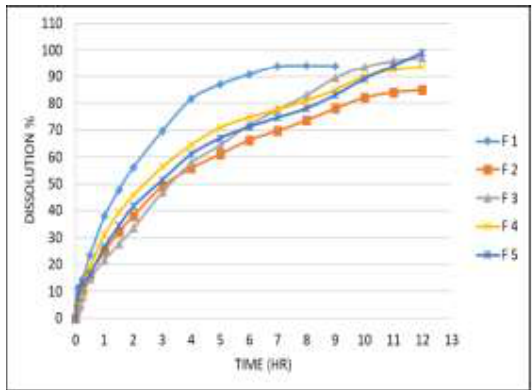
Figure 4. In-Vitro drug release of baclofen tablet